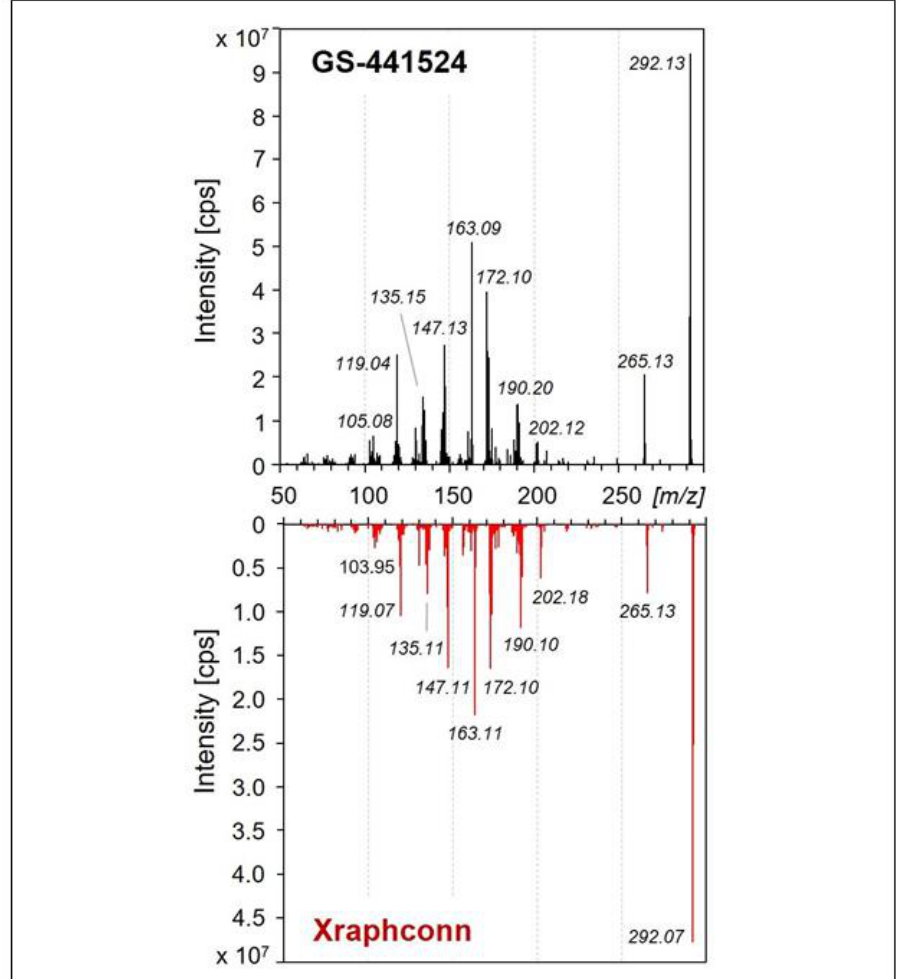
Figure 7. Comparison of the Ultra-High-Performance-Liquid Chromatography Electro-Spray QTRAP Mass Spectrometry (UHPLC-ESI-QTRAP-MS/MS) spectra of GS-441524 and the active component of Xraphconn ® extracted from the tablet. The compounds in both test solutions were not only isobaric with [M + H]+ m/z 292.1040, but exhibited identical fragmentation spectra. Mass spectra were generated at a collision energy of 50 eV with positive ionization using the Multiple Reaction Monitoring with Information Dependent Acquisition and Enhanced Product Ion (MRM-IDA-EPI) scan mode. Cps, counts per second.